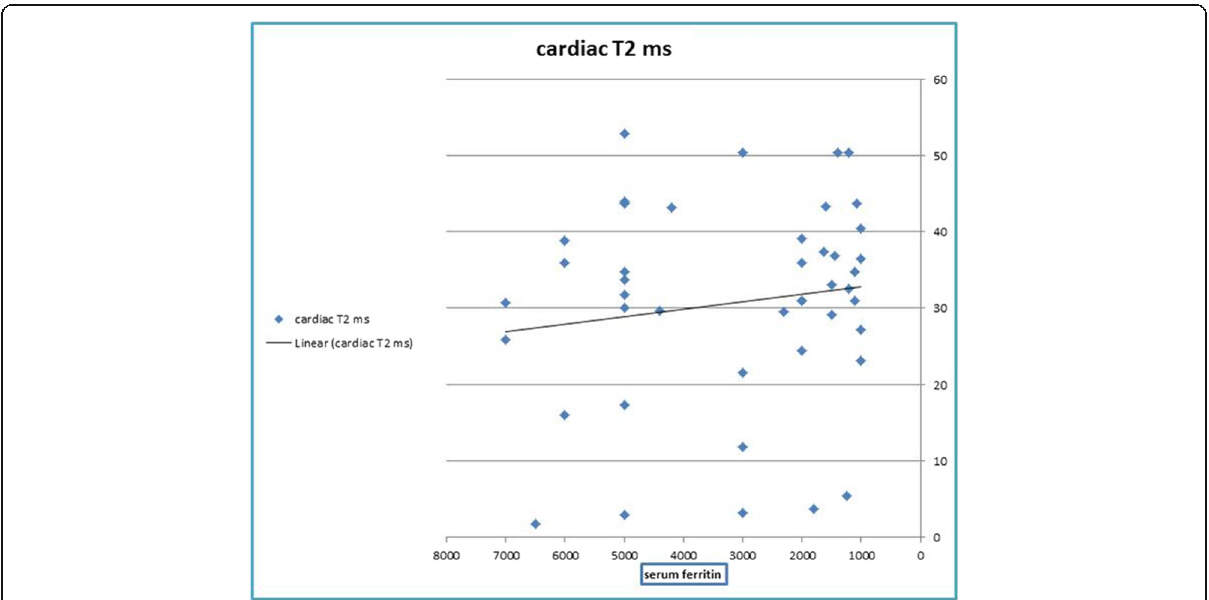
Fig. 4 Scatter plot with line chart for the correlation between serum ferritin and cardiac T2